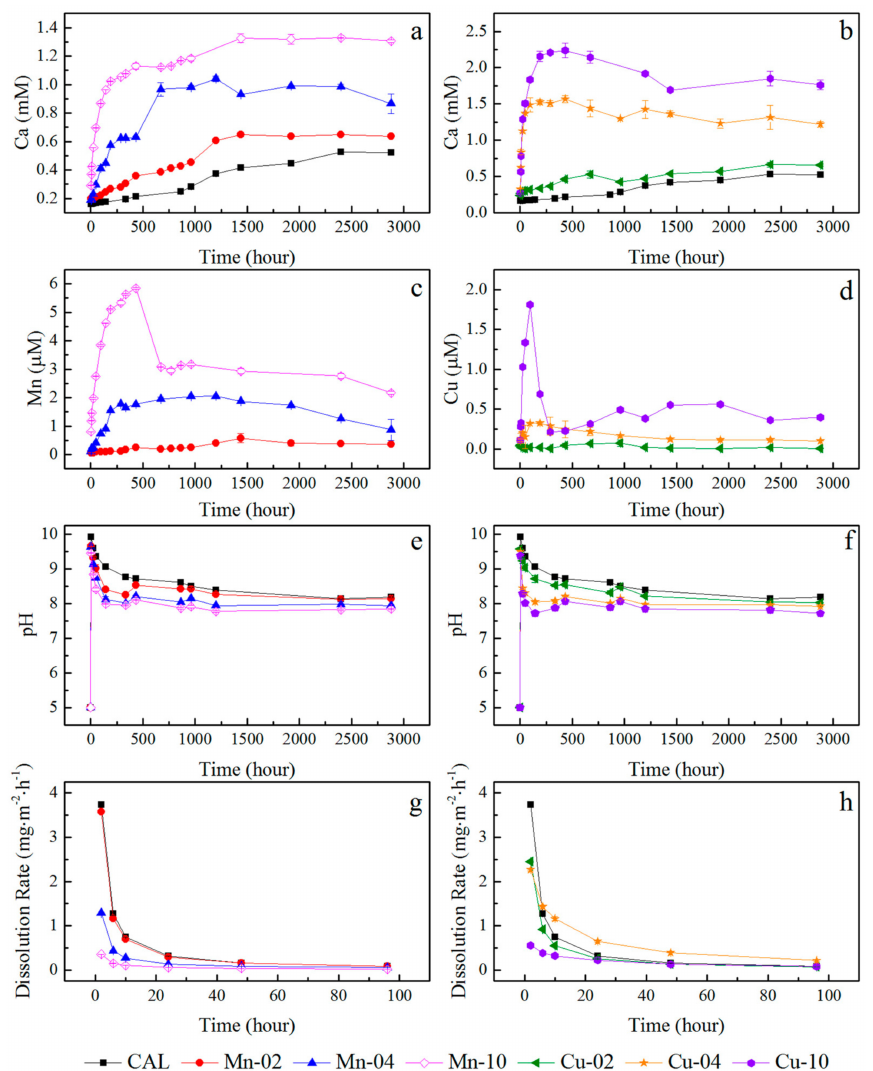
Figure 2. Evolution of aqueous metals and pH during the dissolution of the solid solutions and the corresponding dissolution rates. ( a , b ) Evolution of Ca concentration during the dissolution of the solid solutions; ( c ) Evolution of Mn concentration during the dissolution of Mn-02, Mn-04 and Mn-10; ( d ) Evolution of Cu concentration during the dissolution of Cu-02, Cu-04 and Cu-10; ( e , f ) Evolution of aqueous pH during the dissolution of the solid solutions; ( g , h ) Evolution of the dissolution rates during the dissolution of the solid